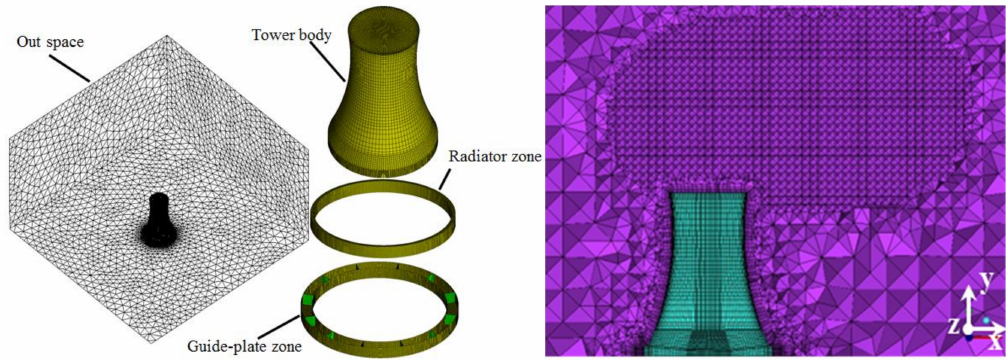
Figure 7. Grid of various parts and the density